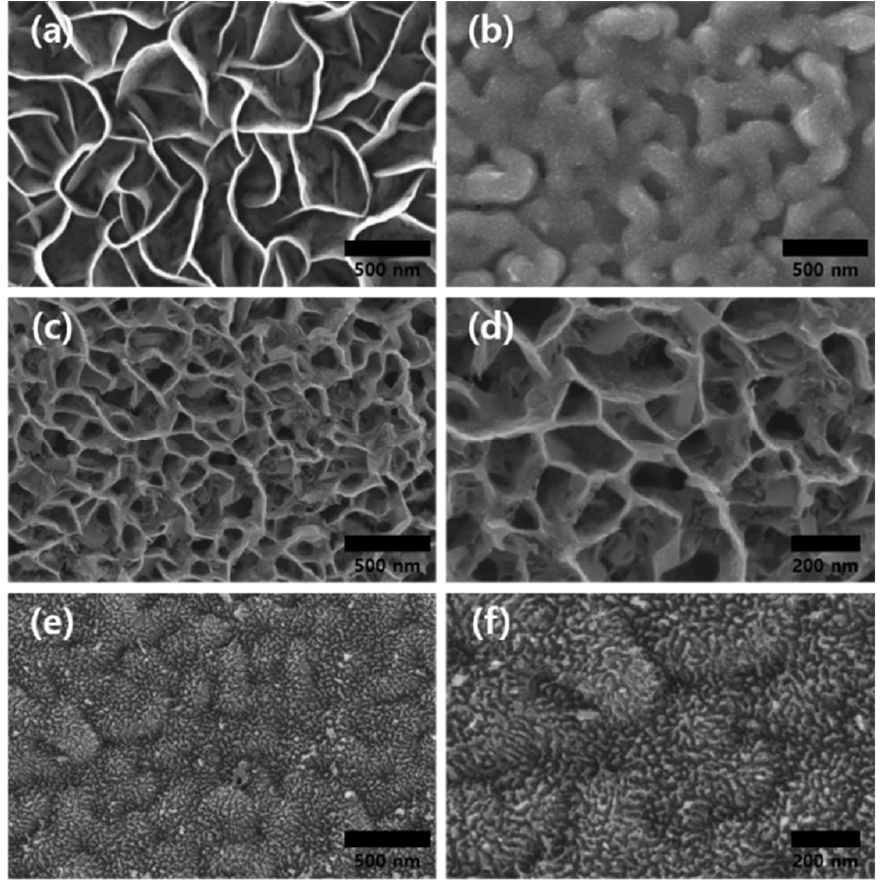
Figure 1. Top view images of the ( a ) pristine carbon nanowall (CNW), ( b ) 500 °C heat-treated am- monium tetrathiomolybdate (ATTM) under hydrogen atmosphere, ( c ) dimethylformamide (DM)– CNW (×50,000), ( d ) DM–CNW (×100,000), ( e ) acetonitrile (AM)–CNW (×50,000), ( f ) and AM–CNW 09 ( × 100,000).